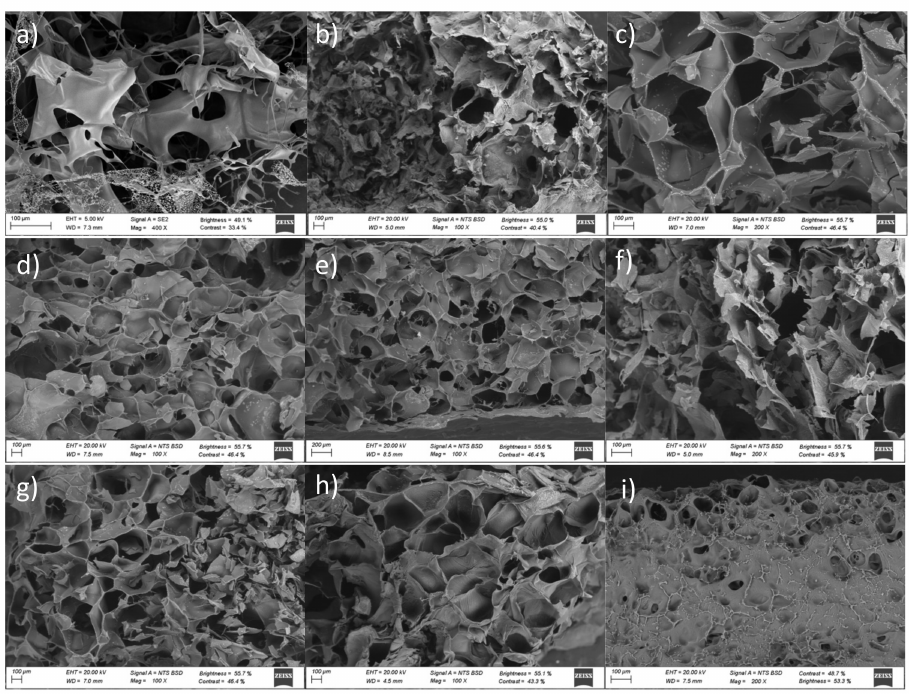
Figure 6. SEM images of ( a ) 1%, ( b ) 3%, and ( c ) 5% HAMA; ( d ) 2% and ( e ) 10% GelMA; ( f ) 1% HAMA-2% GelMA; ( g ) 5% HAMA-2% GelMA; ( h ) 1% HAMA-10% GelMA; and ( i ) 5% HAMA-10%